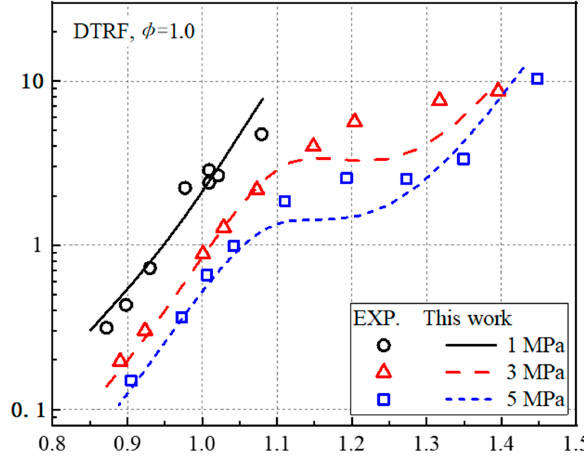
Figure 9. Verification of the ignition delay time of DTRF.